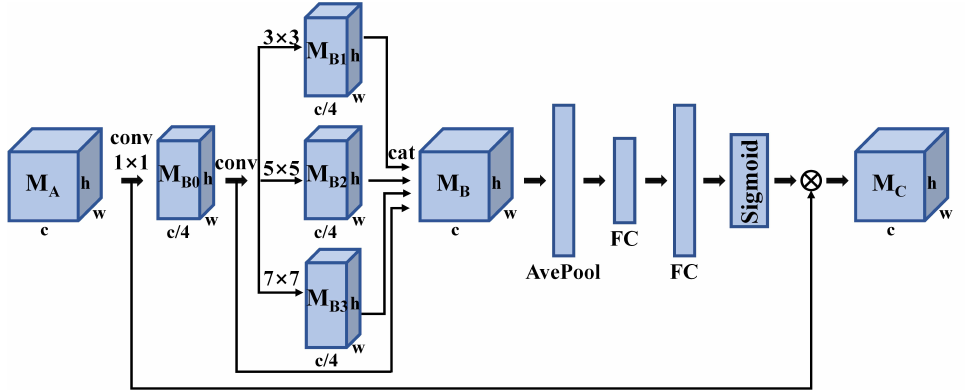
Figure 3. The structure of the MCAM. We apply appropriate padding to ensure the same output